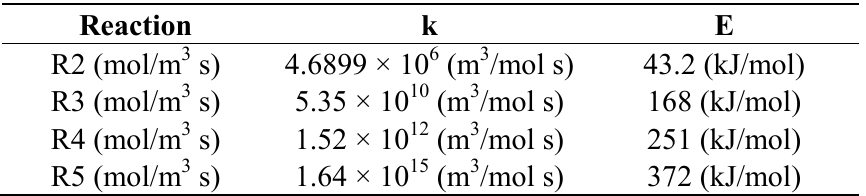
Table 3. Parameters of gas phase